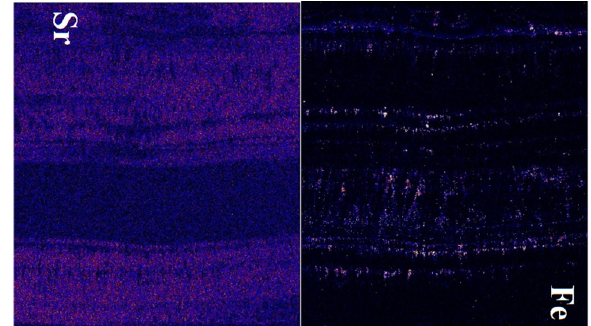
Figure 6: Synchrotron X-ray fluorescence microscopy data showing the negative correlation between iron (Fe) and strontium (Sr) in a flowstone at Haasgat. The Fe distribution (lighter in the figure) is dominated by the layering of the calcite in the flowstone and is likely detrital from flooding events between flowstone formation. However, it appears that some Fe also occurs along crystal growth boundaries between these laminated layers and may have been introduced into the flowstone during calcite formation. Areas of higher strontium are lighter.